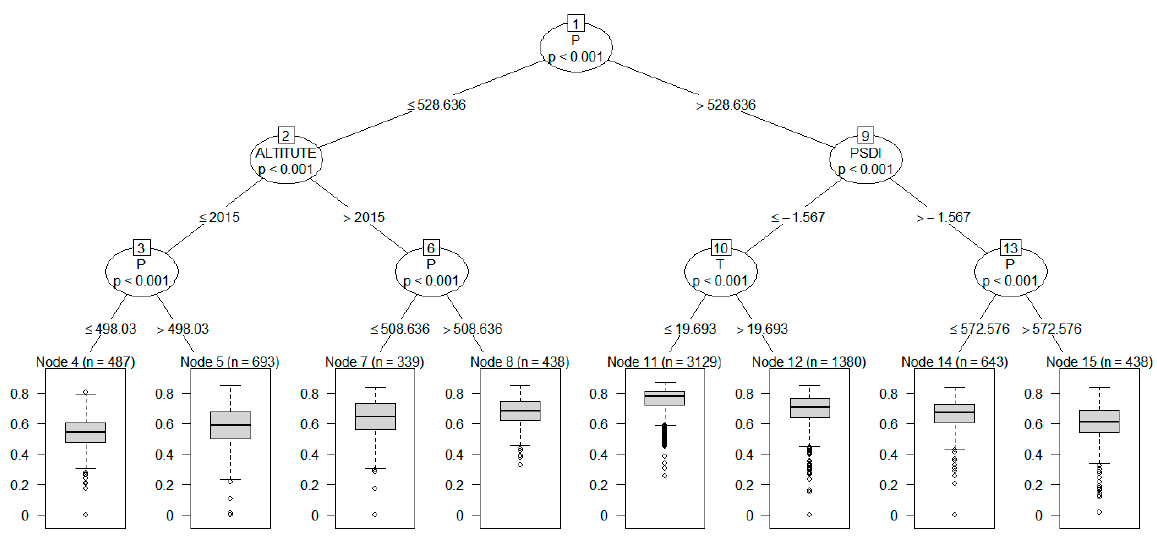
Figure 7. Change trend of NDVI in Qin Mountains (1981–2018).